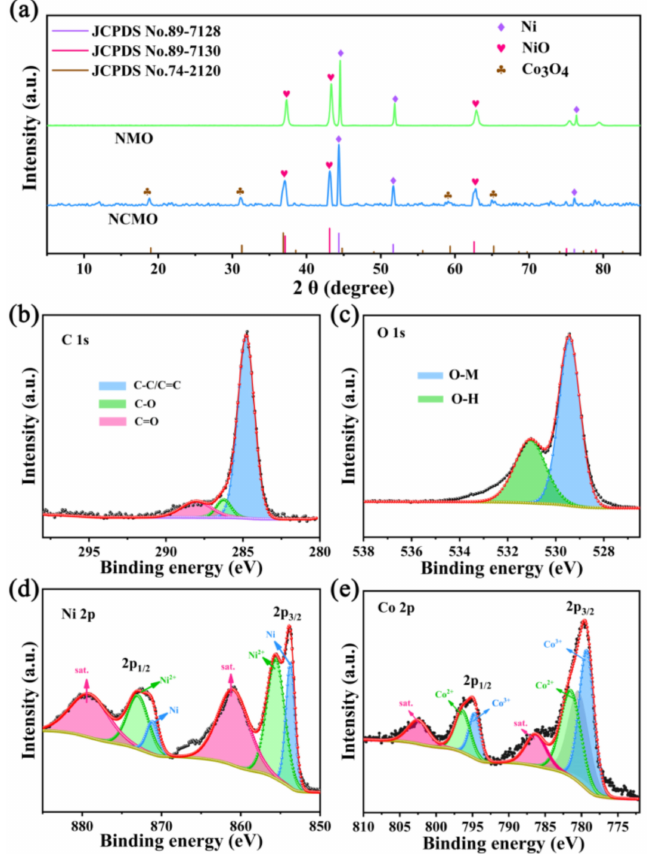
Figure 1. ( a ) XRD patterns of NCMO and NMO; XPS spectra of NCMO: ( b ) C 1s; ( c ) O 1s; ( d ) Ni 2p; ( e ) Co